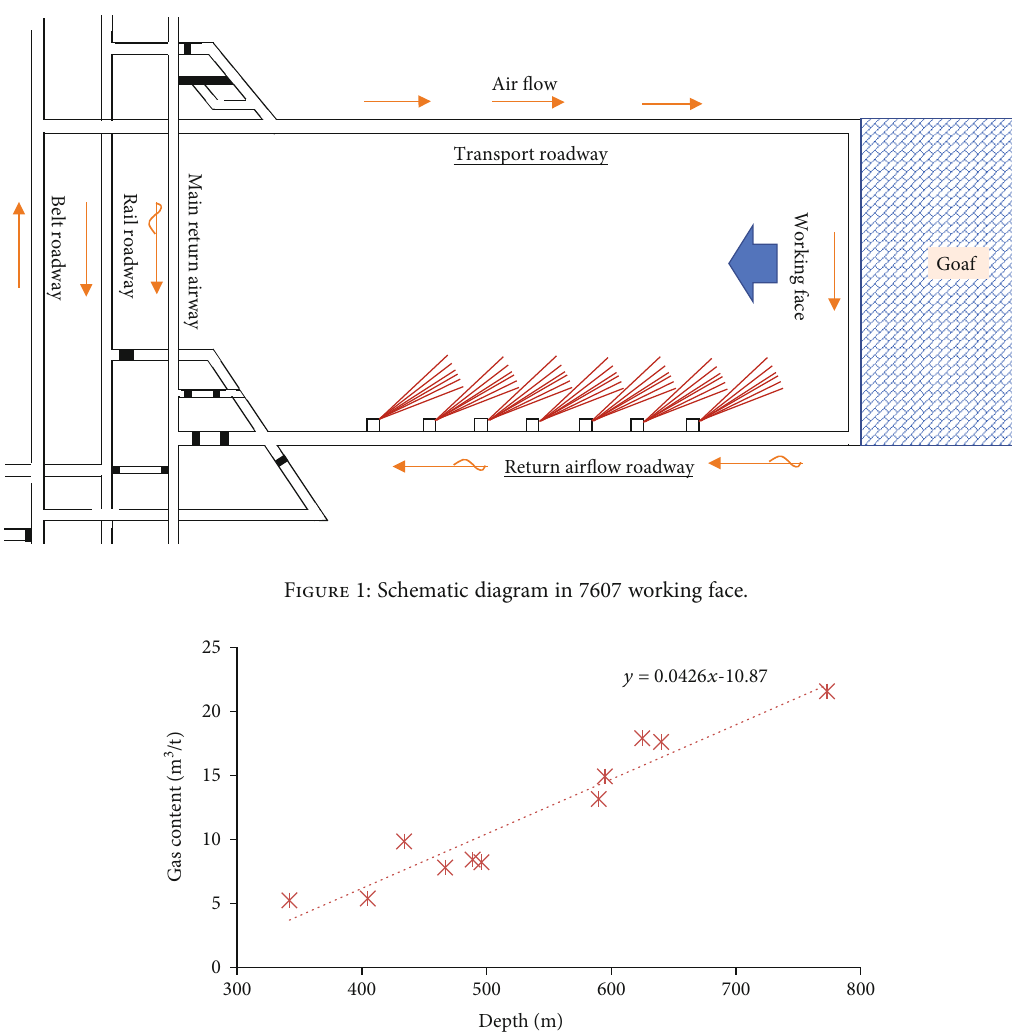
Figure 2: The relationship between the gas content and the buried depth of the 3# coal seam.